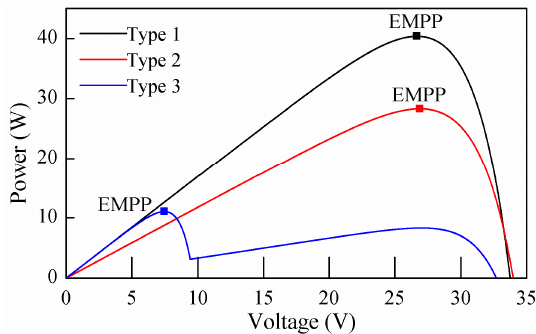
Figure 9. P-V curve of three types of PV panel. Figure 9 . P-V curve of three types of PV panel.